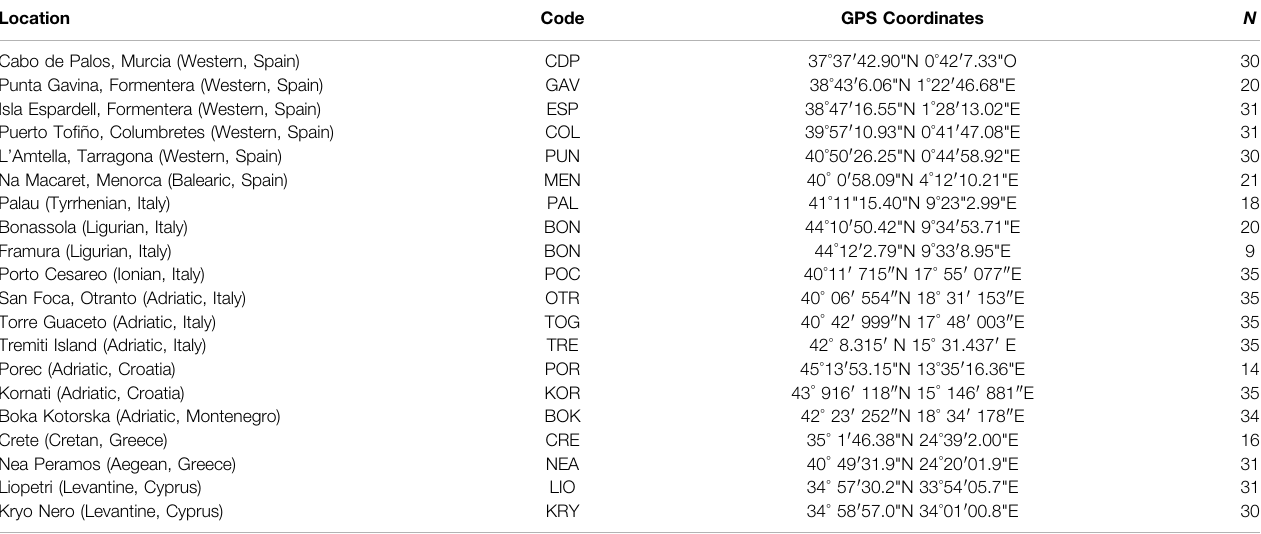
TABLE 1 | List of the sampling localities of C. caespitosa. For each location, sub-basin and country are indicated in parentheses. Also provided are the population codes, GPS coordinates and number of samples ( N ) collected from each locality. Location